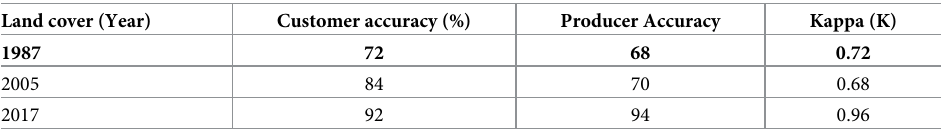
Table 1. Accuracy assessments of land cover